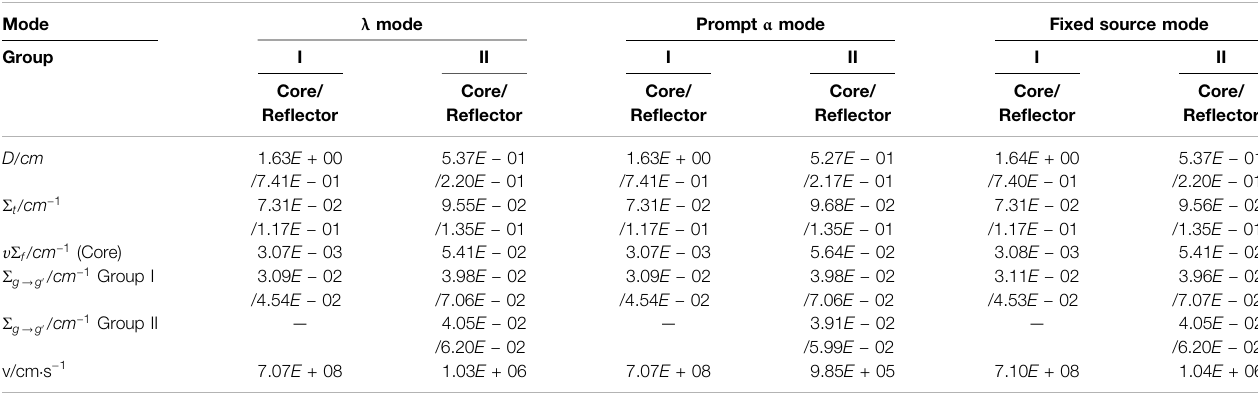
TABLE 4 | Homogeneous and condensate parameters of core/re fl ector in ADSR (k eff (cid:2) 0.93).